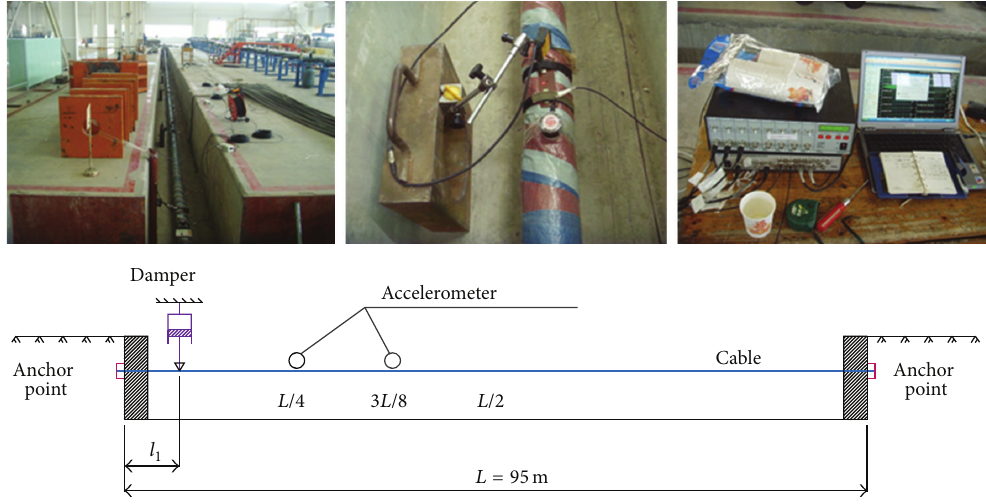
Figure 10: Real cable-damper system test in